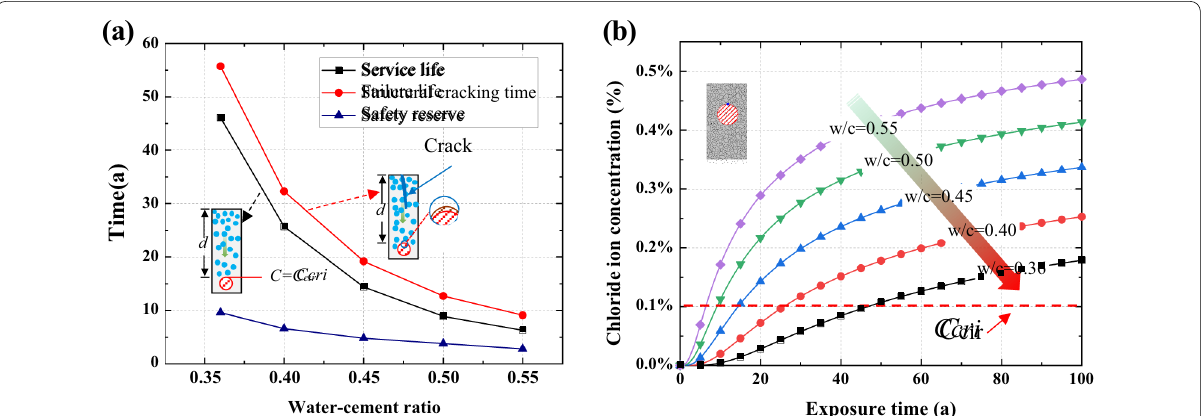
Fig. 6 Effect of water–cement ratio on service life and chloride concentration distribution. a Service life. b Chloride concentration distribution.